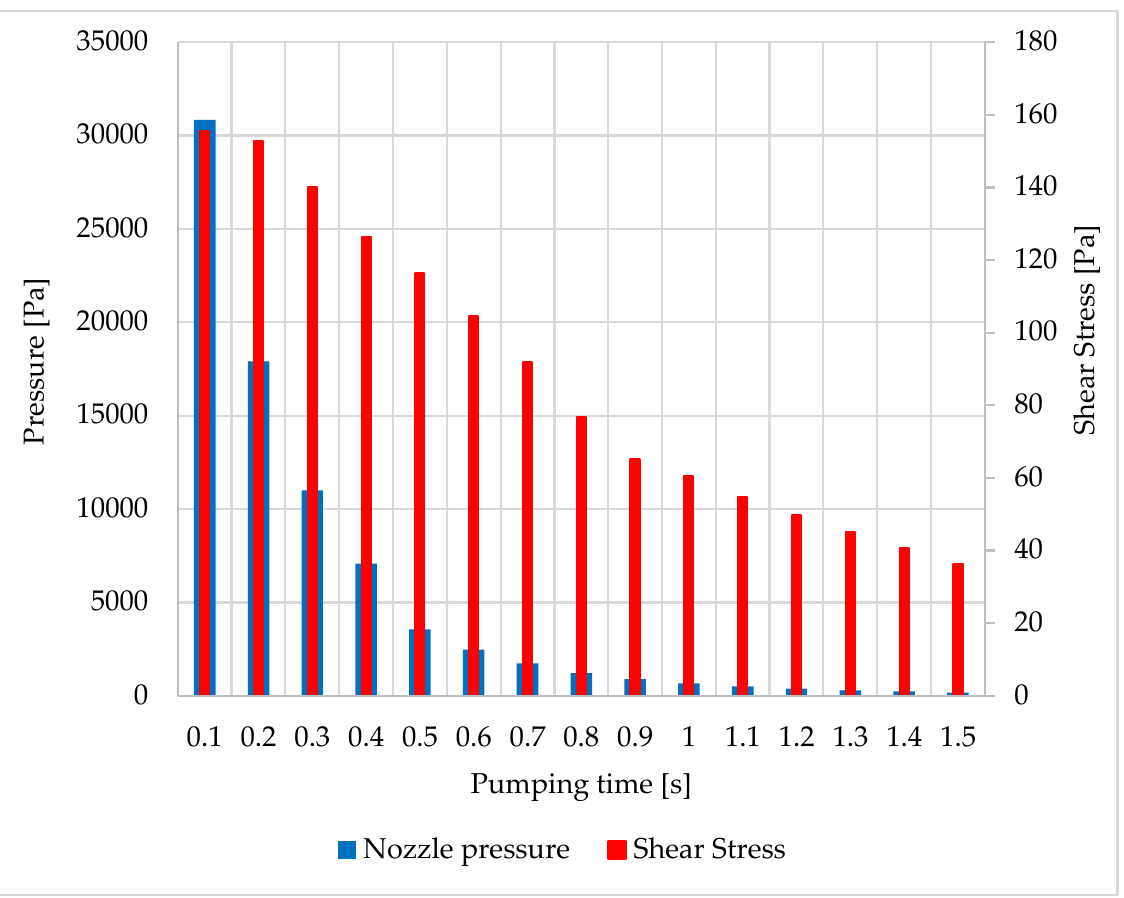
Figure 12. The course of monitored variables during chamber pumping.